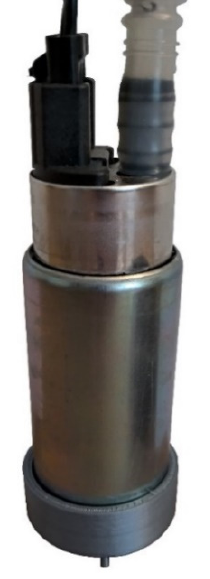
Figure 5. Measured motor in a printed plastic holder.